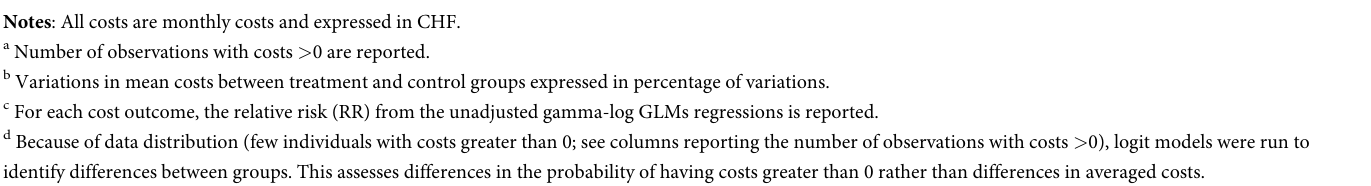
psychiatric care accounted for 11% of hospital costs on average, only 35 of 250 participants used this type of service (21 in the control group and 14 in the treatment group) during the 12 months of follow-up. and total (-4%) costs than did the control group, although the differences were not statistically significant. Somatic inpatient costs for patients in the treatment group were 3% higher than those for the control group, but the difference, again, was not statistically significant. Participants